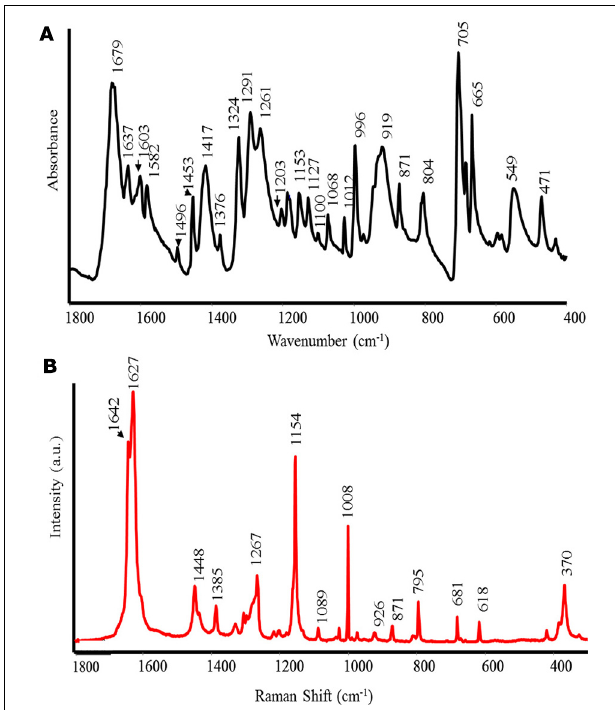
FIGURE 2 | FT-IR (A) and Raman (B) spectra of red grape (RG) biostimulant.